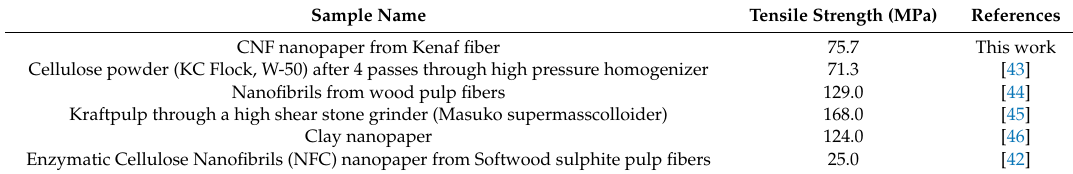
Figure 10. Tensile stress vs. strain curves of the fabricated cellulose nanopapers with varying concentrations. Table 1. Tensile strength of some cellulose nanopapers fabricated via various techniques. Table 2 : Mechanical properties of CNF nanopapers with different CNF content.